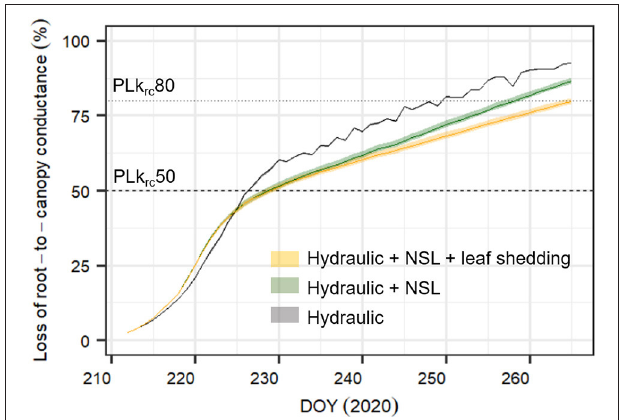
FIGURE 9 | Daily averaged cumulated benefit of observed leaf shedding in preventing loss in root-to-canopy conductance ( PLk rc , in %) for minimum leaf conductance (g min ) = 2 mmol m − 2 s − 1 (blue continuous line), and g min = 3 mmol m − 2 s − 1 (red dashed line). Results represent the median ± 95% CI of 500 model simulations obtained by randomly sampling the posterior parameter distribution for each of the following scenarios and their combination:with and without leaf shedding, and the two g min values considered. The daily average cumulated difference in PLk rc between shedding and no shedding is calculated according to Equation 14. The vertical lines for both scenarios indicate the DOY at which the benefit of leaf shedding is significantly >